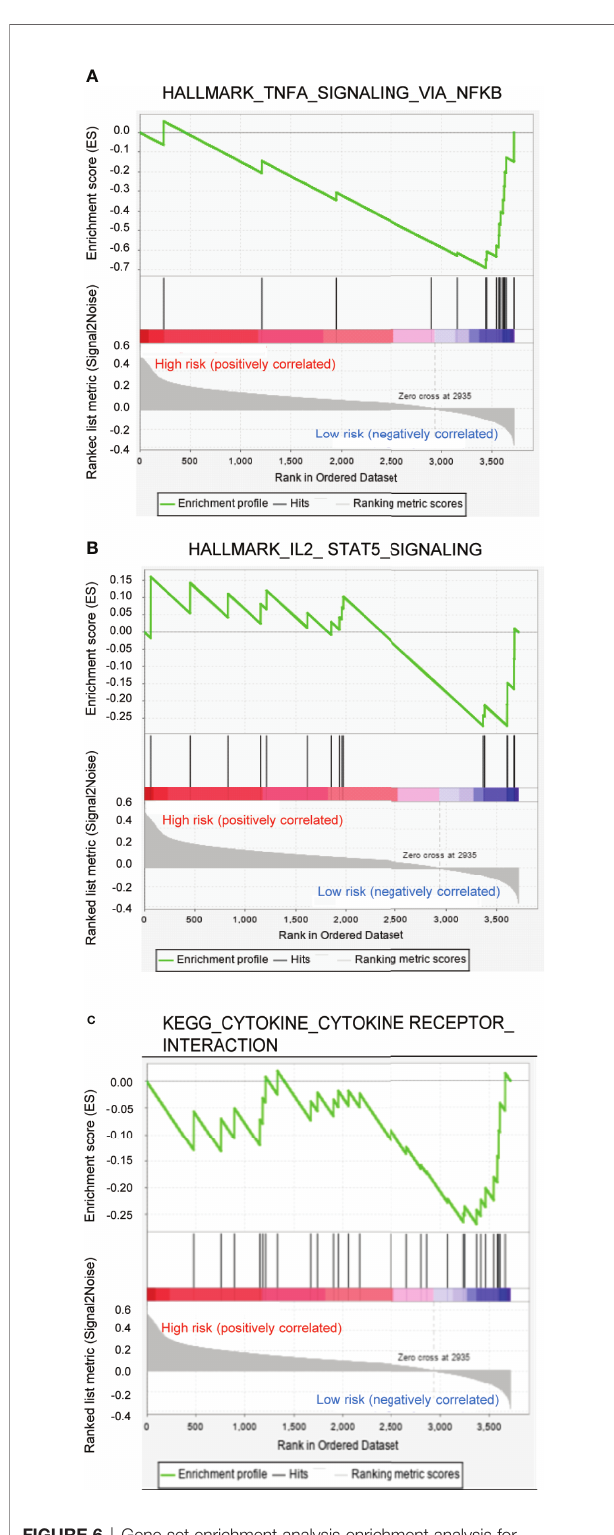
FIGURE 6 | Gene set enrichment analysis enrichment analysis for ferroptosis-associated lncRNA signature. (A, B) Two remarkably enriched immune-associated HALLMARK pathways in low-risk patients. (C) Two remarkably enriched immune-associated Kyoto Encyclopedia of Genes and Genomes pathways in low-risk